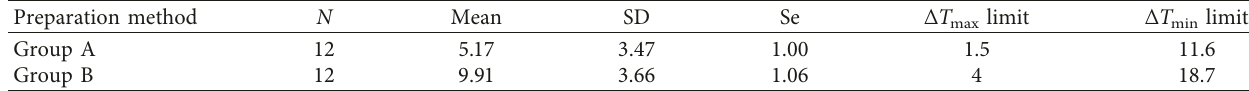
Table 4: The mean, standard deviation, standard error, and maximum and minimum limits of ∆ T.